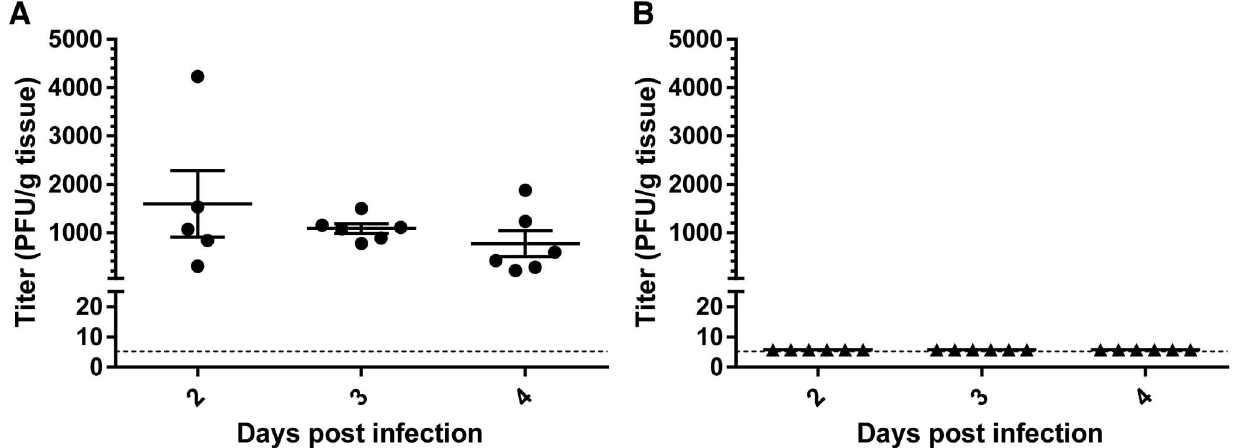
Fig 2. Lung viral titers of IFN- α / β R − / − and C57BL/6 mice challenged with MuV-IA. (A) IFN- α / β R − / − and (B) wild-type C57BL/6mice were challengedi.n. with 1x10 6 PFU MuV-IA in 100 μ L.Lungswere harvestedon 2, 3, and 4 dpi. Tissues were weighedand homogenized and viral titers were determinedby plaqueassay in duplicate.The limit of detectionof 5.8 PFU/g tissue is representedby the dashed line.